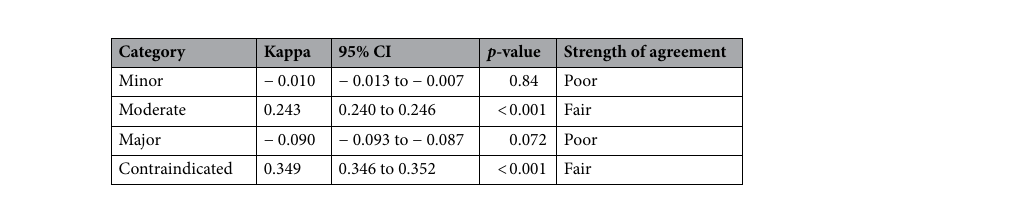
Table 4. Agreement among three drug-interaction